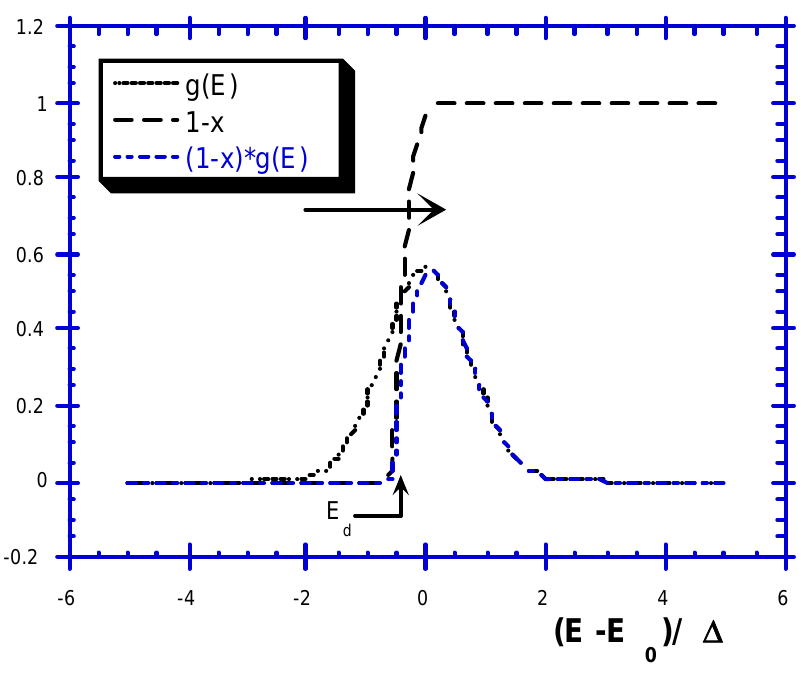
Figure 35. Effect of an annealing on B distribution: annealing will erase the less stable